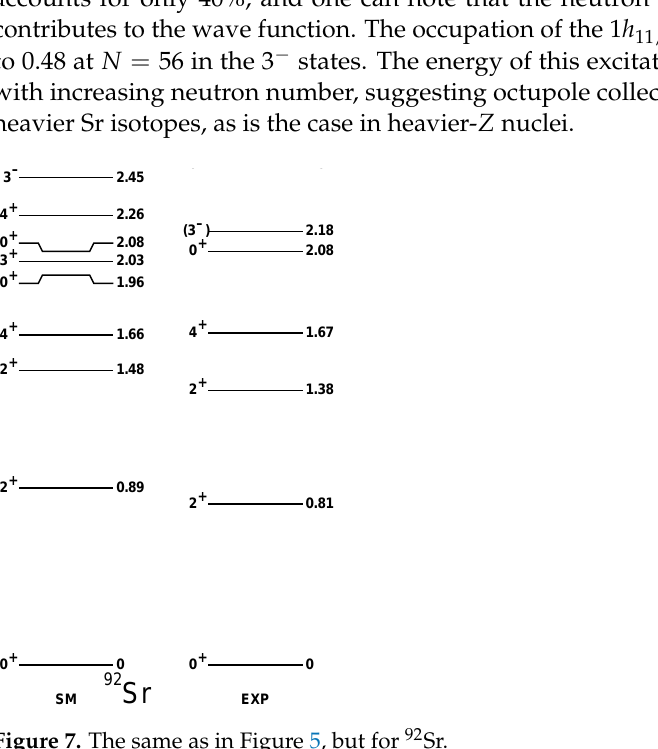
Figure 7. The same as in Figure 5, but for 92 Sr.